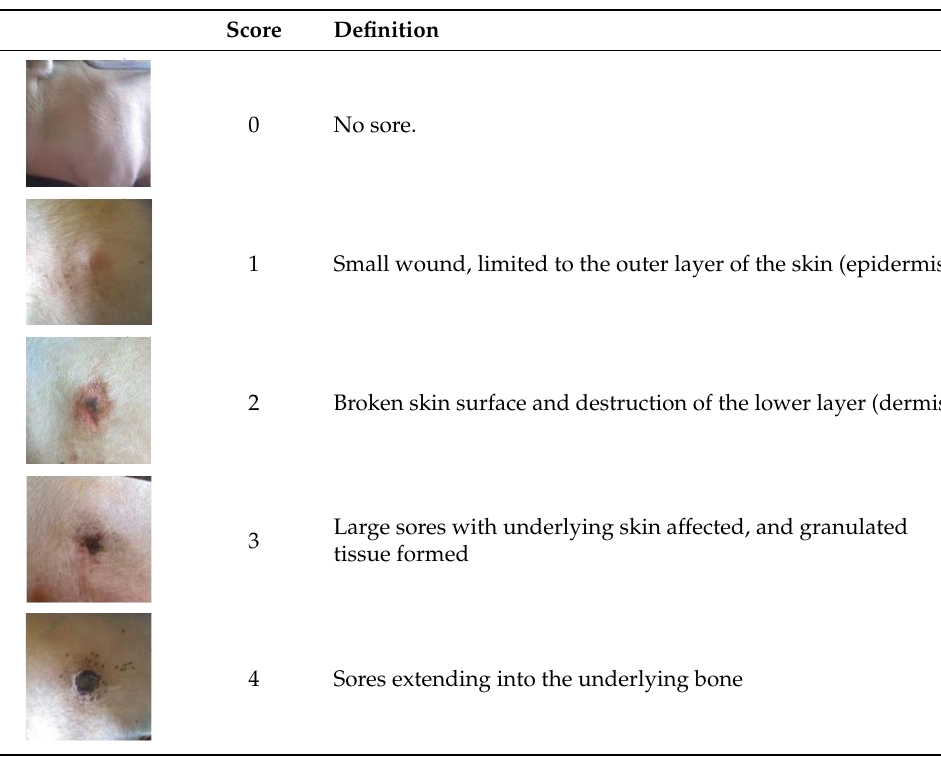
Table 1. Grading system (severity score) used for assessing sores on clinical inspection [5].